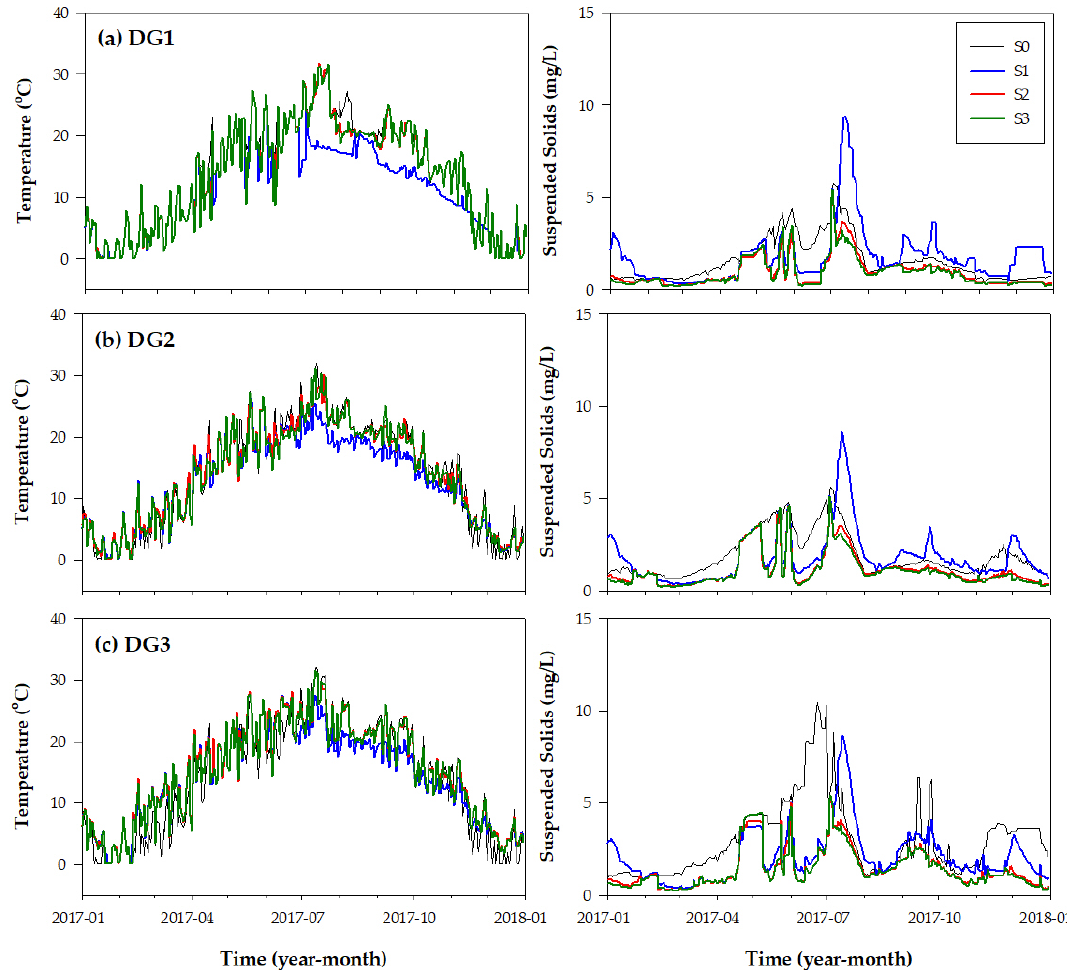
Figure 6. Comparison of the temperature and SS concentration under the in-lake management practices in Doam Lake and the installation of constructed wetlands in Kangnung Namdae Stream at ( a ) DG1, ( b ) DG2, and ( c ) DG3.